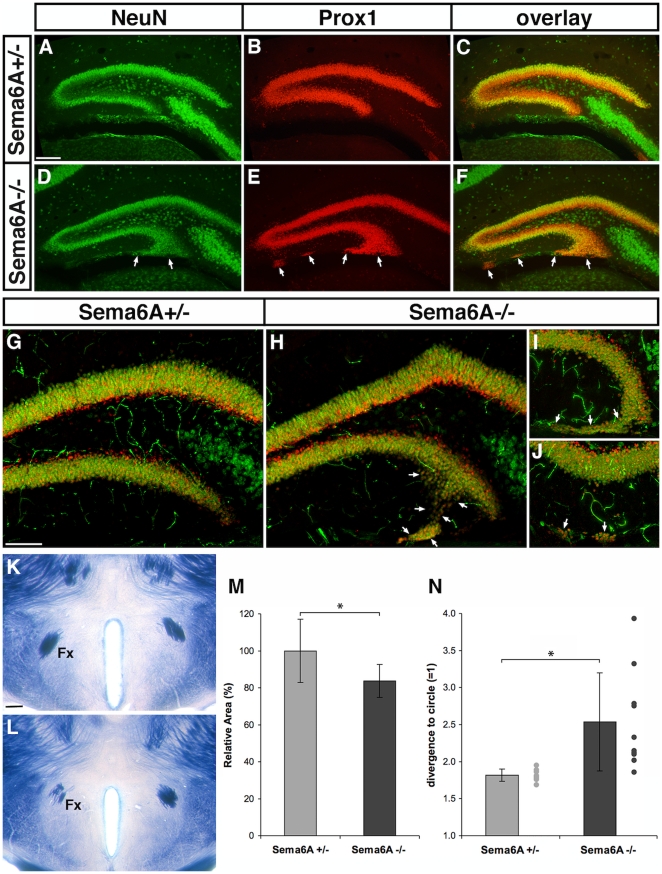
Alterations in hippocampal lamination and projections.(A–F) Immunohistochemistry for NeuN (A, D; green, neurons) and Prox1 (B, E; red, dentate granule cells; overlay in C and F) on coronal brain sections from P10 Sema6A+/− (A–C) and Sema6A−/− (D–F) mice. Sema6A−/− mice show a broadening of the granule cell layer at the tip of the infrapyramidal blade of the dentate gyrus as well as more isolated clusters of ectopic granule cells at the surface of the molecular layer of the same blade (arrows in D–F). (G–H) Overlays of NeuN- (green) and Prox1- (red) immunostained adult brain sections of Sema6A+/− (G) and Sema6A−/− (H–J). Similarly distributed ectopic granule cells (arrows in H–J) are still present in the adult dentate gyrus. (K–L) PLAP-stained adult brain sections showing a reduced and defasciculated fornix (Fx) in Sema6A−/− (L, left fornix) compared with Sema6A+/− mice (K). The fornix is significantly reduced in size by 20% (M; p<0.05) and is significantly less compact (N; measured as the ratio of actual and circular perimeter; p<0.01) in Sema6A−/− (n = 10) compared to Sema6A+/− mice (n = 8). Error bars in (M, N) represent ± SD; *: significant. Dots plotted on the right of columns in (N) are individual data points. Scale bar in (A) is for (A–F), in (G) is for (G–J), and in (K) is for (K, L): 200 µm.